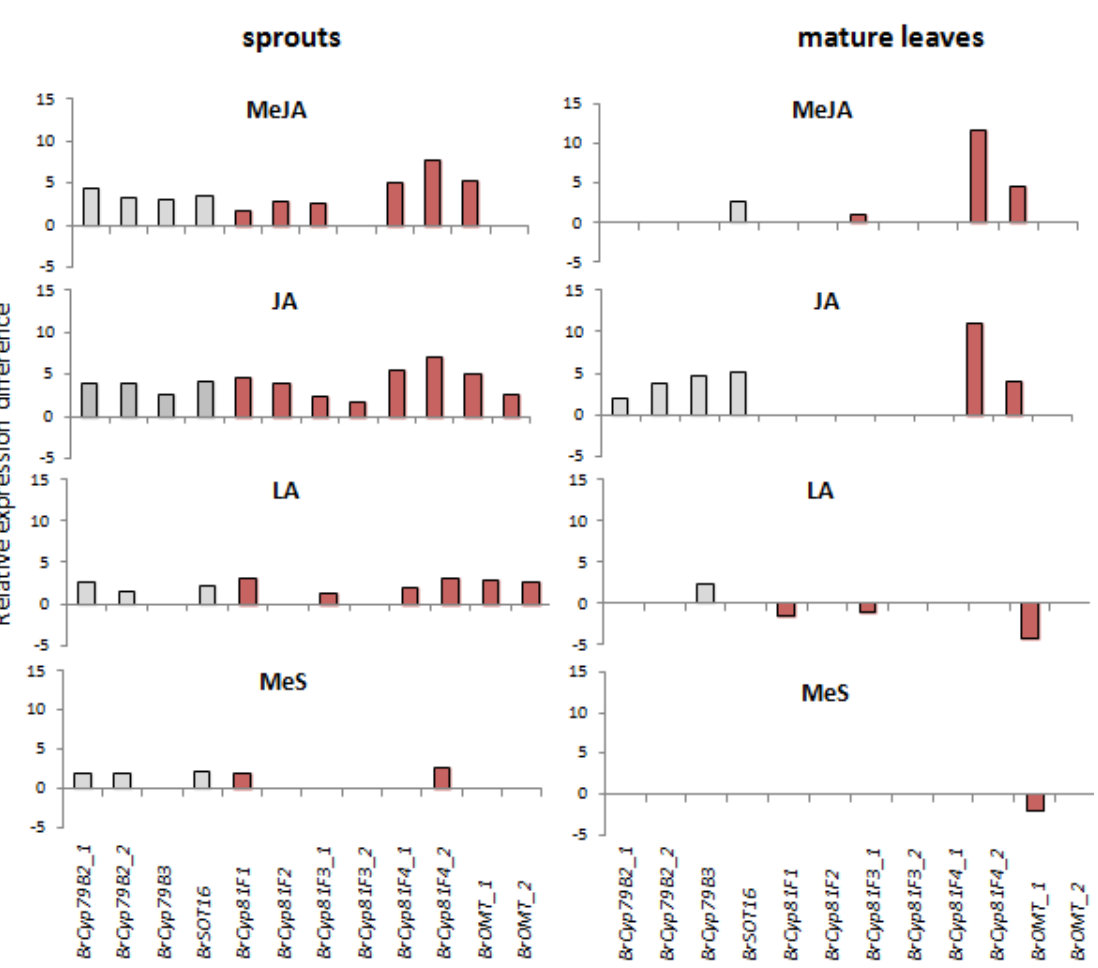
Figure 6. Relative expression difference of genes involved in indole glucosinolate biosynthesis in sprouts and mature leaves. Relative expression difference of genes involved in core biosynthesis of indole glucosinolates (light gray bars) and putative modifying genes (light red bars) are shown. Left diagrams show expression in sprouts, right diagrams show expression in mature leaves treated with following elicitors: MeJA, methyl jasmonate; JA, jasmonic acid; LA, linolenic acid; MeS, methyl salicylate. Each value represents relative expression difference calculated as ΔΔ CT from three biological replicates obtained from semi-quantitative RT-PCR analysis. For mapping the different abbreviations, please see Table 1. Only significant changes in gene expression levels after elicitor treatment compared to control plants are shown (Dunnett test, p ≤ 0.05) (for details see basic data of gene expression levels in Table